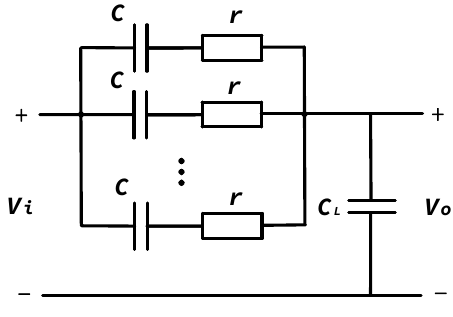
Figure 5. Equivalent circuit model of the variable capacitor